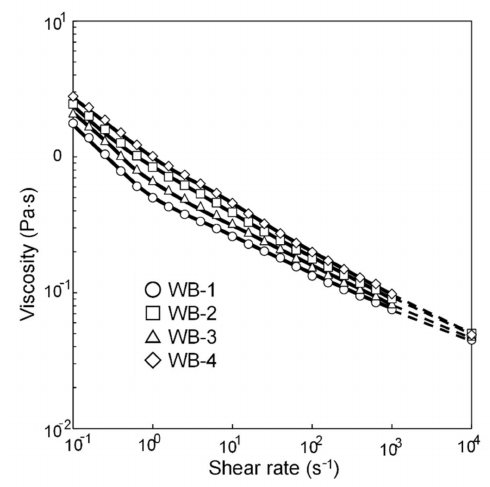
Figure 11. Shear rate dependence of viscosity of waterborne basecoats.